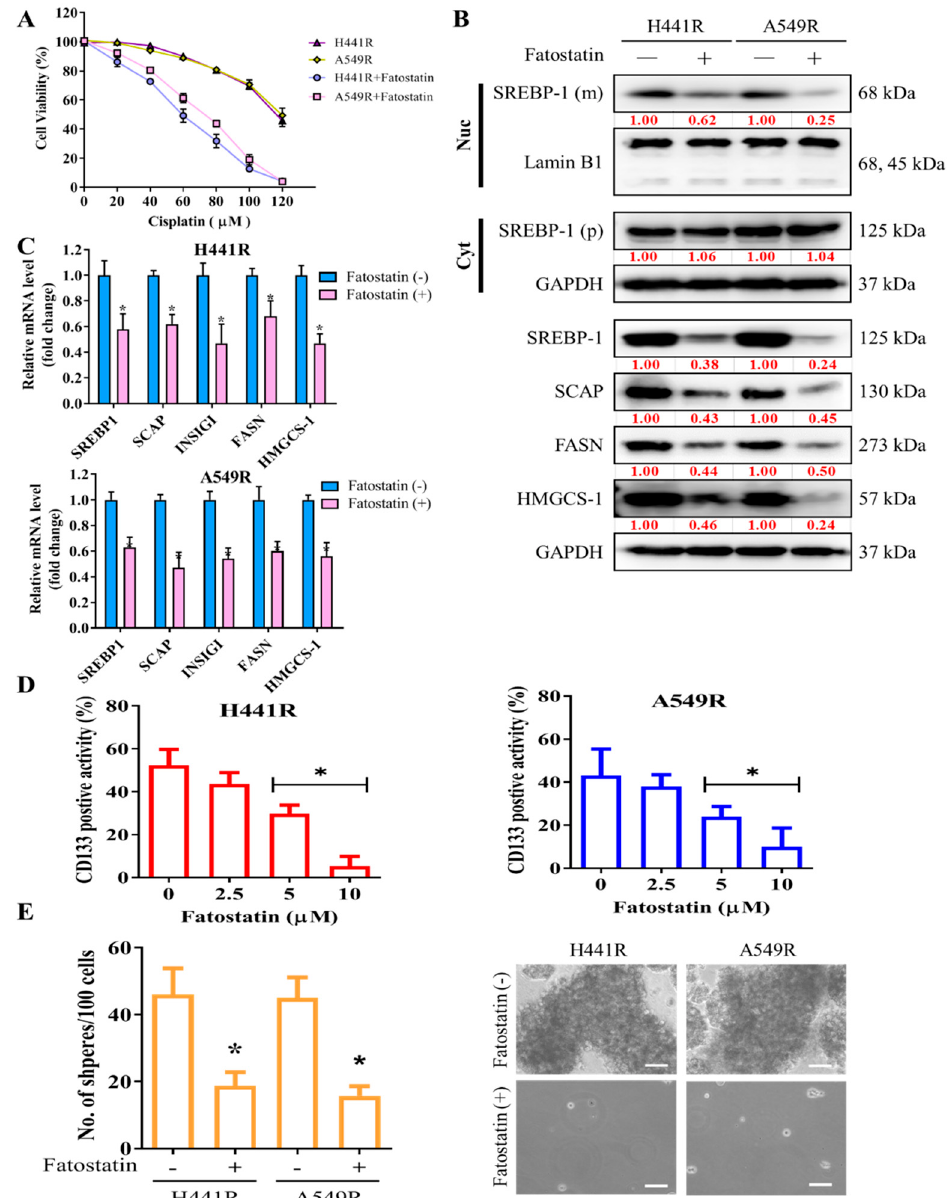
Figure 3. Fatostatin treatment decreased cisplatin resistance and cancer stemness in NSCLC cells. ( A ) Graphical representation of the effect of 20- to 120- µ M cisplatin on A549R and H441R cells left untreated or pretreated with 5 µ M fatostatin. ( B ) Representative Western blot images indicating protein expression of mature (m) SREBP-1 undergoing cleavage in nuclear (Nuc) compartment (top panel), precursor (p) SREBP-1 in cytoplasm (Cyt), and constitutive expression of SCAP, INSIG1, FASN, and HMGCS-1 in whole lysate of A549R and H441R cells either left untreated or treated with 5-µM fatostatin for 24 h. Lamin B1 and GAPDH were loading control of nuclear and whole lysate, respectively. ( C ) Bar chart showing the comparative expression of SREBP-1, SCAP, FASN and HMGCS-1 mRNA in H441R and A549R cells treatment with/without 5µM Fatostatin. ( D ) Effect of 2.5- to 10- µ M fatostatin on the percentage of CD133+ A549R and H441R cells, as demonstrated by flow cytometry. ( E ) Images and graphical representations of the effect of 5- µ M fatostatin on the number and size of spheres formed by A549R and H441R cells. Data are represented as means ± SDs from assays performed in triplicate at least 3 times. * p <